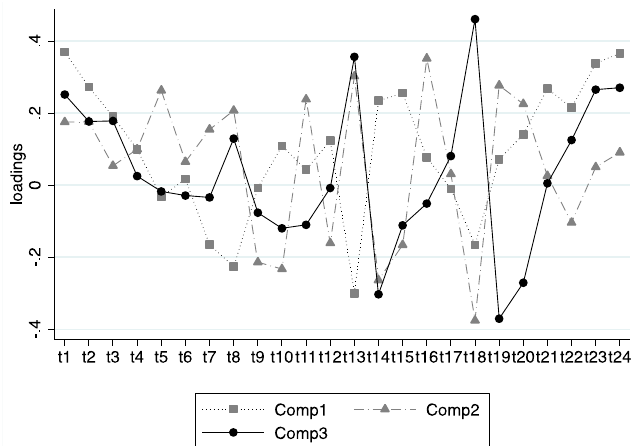
Figure 1. The loadings of the diurnal eating patterns on the variables indicating the energy intake across 24 hours of the day based on performing a Principal Components Analysis on the correlation matrix.